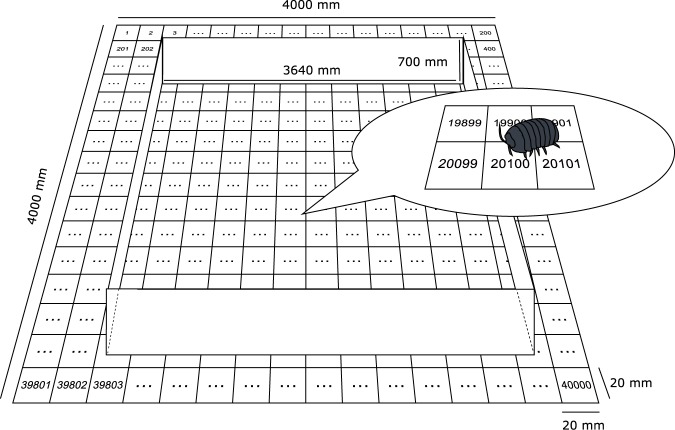
Diagram of the large arena.At the beginning of each experiment, a single pillbug was placed in the center of the arena, which is the lattice point surrounded by lattices numbered 19900, 19901, 20100, and 20101.